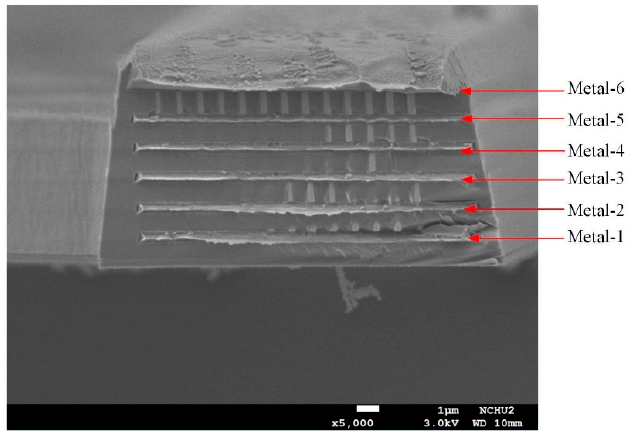
Figure 13. A cooling sheet image taken by SEM.